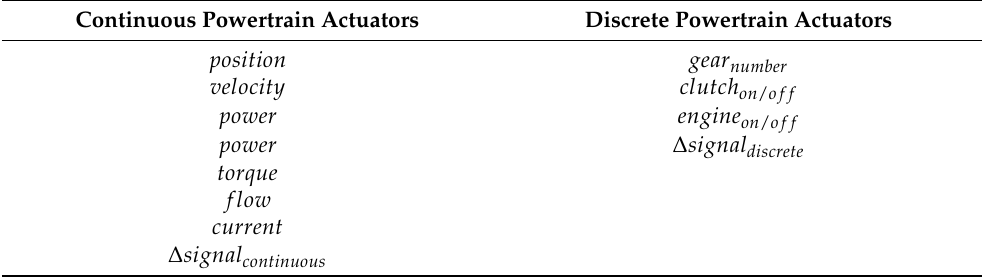
Table 2. Example signals that a powertrain controller could be expected to schedule.